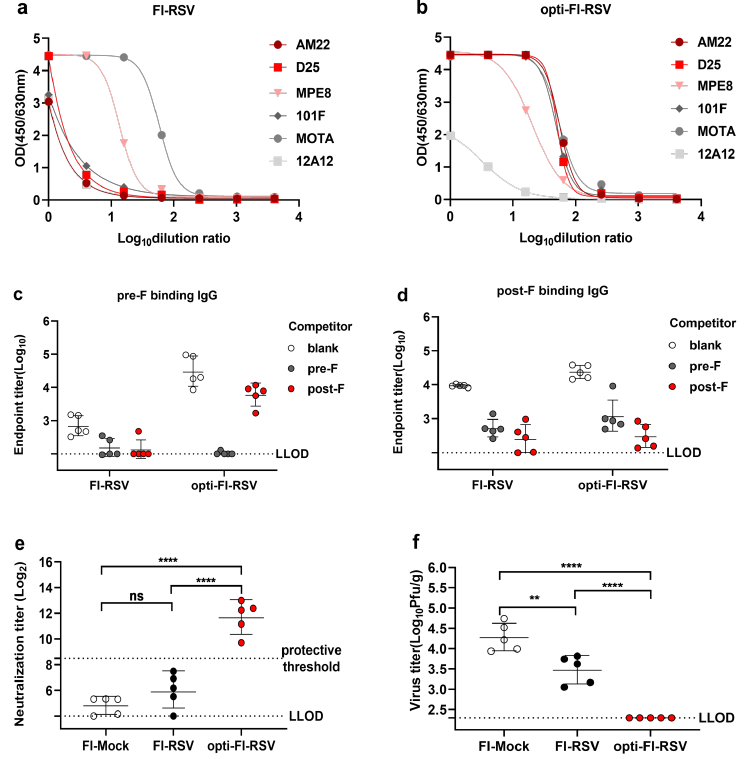
Figure 3. Opti-FI-RSV is immunogenic and protective without causing ERD in cotton rats. Female cotton rats (n = 5 per group) were injected intramuscularly with FI-Mock, FI-RSV or opti-FI-RSV in a prime-boost regimen at week 0 and week 3. Animals were challenged with the RSV A2 strain intranasally at a titer of 1 × 10 6 PFU on day 49. ( a , b ) Serial dilutions of the vaccine were incubated with biotinylated pre-F specific antibodies (AM22, D25, AM14) and total F target mAbs (MPE8, 101F, MOTA) or a post-F-specific mAb (12A12), and a secondary mAb conjugated with streptavidin was used to test the binding of the vaccine and the mAb. ( c , d ) Pre-F- and post-F-specific antibody levels were determined using a competitive ELISA. ( e ) Serum neutralizing antibody titers were measured using RSV A2 as described in the Materials and Methods. ( f ) RSV virus titers were determined in the right lung homogenate of cotton rats at day 5 after challenge as determined by PFU. The symbols indicate individual rats, the bars/lines indicate the geometric mean ± geometric SD, and the dotted lines indicate the lower limit of detection and the protective threshold. ( e , f ) The data were analyzed by one-way ANOVA followed by Tukey’s multiple comparisons post hoc test to analyze the differences between vaccination groups. The p values are shown by asterisks (ns = not significant; ** p < 0.01; **** p <